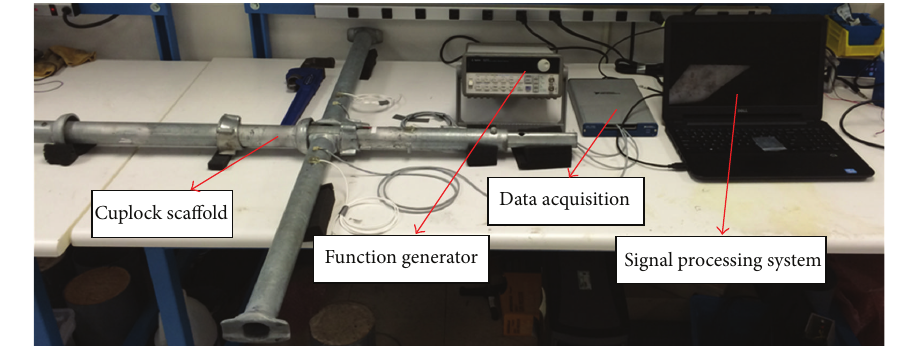
Figure 4: Experimental setup.